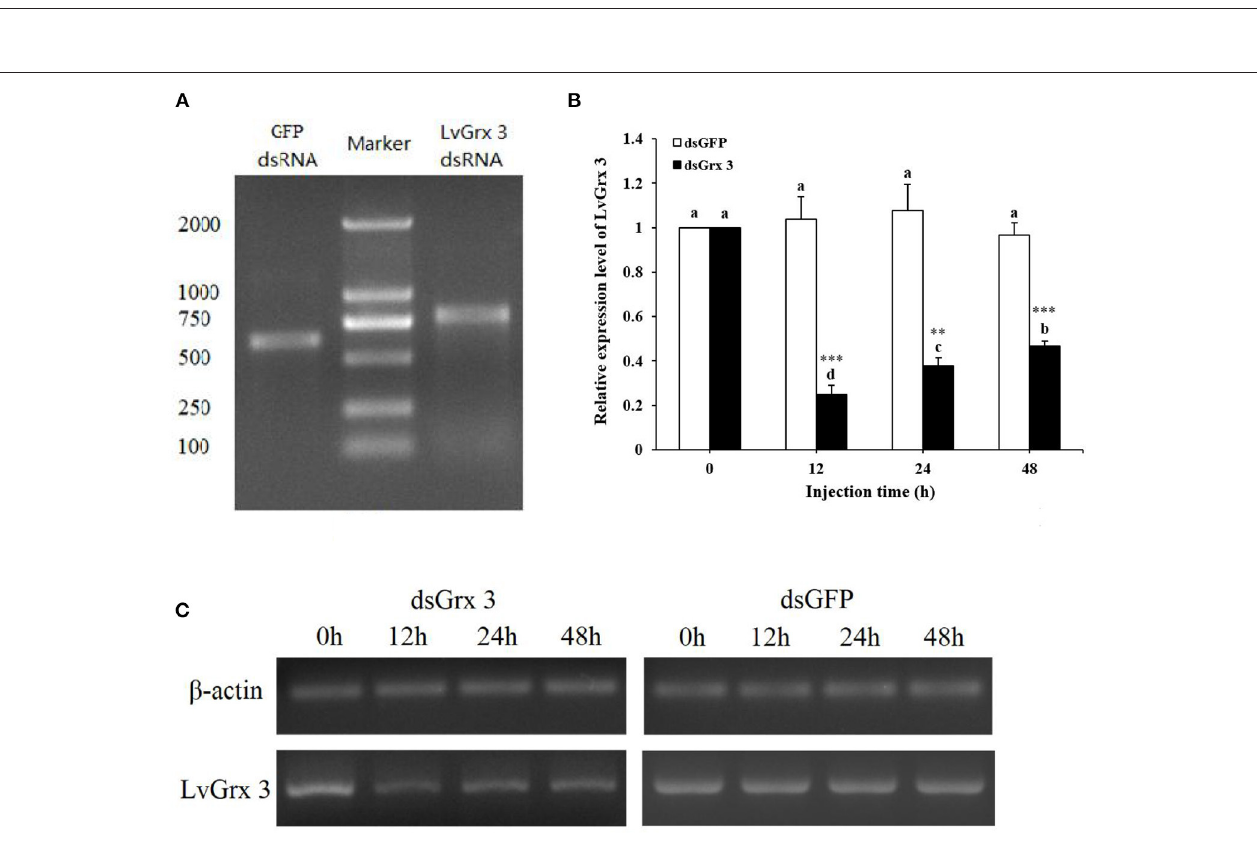
FIGURE 9 | Quality of dsRNA synthesized in vitro and silencing efficiency of LvGrx 3 dsRNA injection. (A) Detection of purified dsRNA of GFP and LvGrx 3 genes by agarose gel electrophoresis. Lane 1, LvGrx 3 dsRNA; Lane 2, DNA marker (DL 2000, Takara, Dalian, China); Lane 3, GFP dsRNA. (B) Efficiency of dsRNA knock down of LvGrx 3 expression levels. Hepatopancreas samples from each shrimp were collected after LvGrx 3 or GFP dsRNA injection for quantitative reverse transcription-polymerase chain reaction (qRT-PCR) analysis. Data are expressed as means ± standard deviation (SD) relative to the untreated group (0h). Significant differences between dsGrx 3 and dsGFP-injected shrimps at the same exposure time are indicated with asterisks (* P < 0.05; ** P < 0.01; *** P < 0.001). The calculated data in the same group with different letters are significantly different ( P < 0.05). (C) LvGrx 3 expression in dsGFP and dsGrx 3-injected shrimps by semi-quantitative real time-polymerase chain reaction (RT-PCR). The β -actin gene was used as a control.